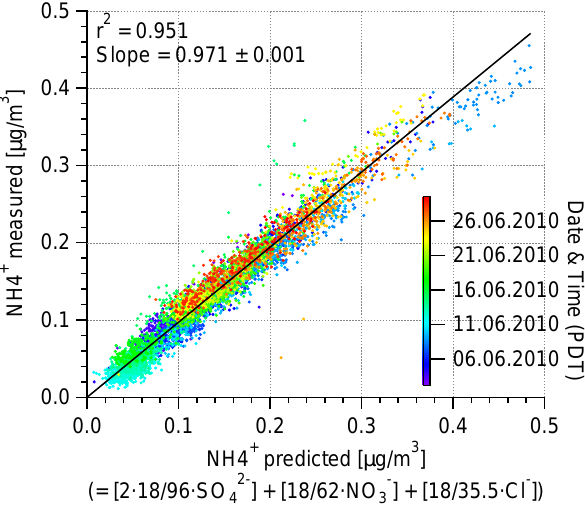
Fig. 3. Scatterplot of AMS total + BC mass vs. SMPS volume in the size range 25–714nm ( D m ), colored by time. The data fitting was performed using the orthogonal distance regression (ODR).